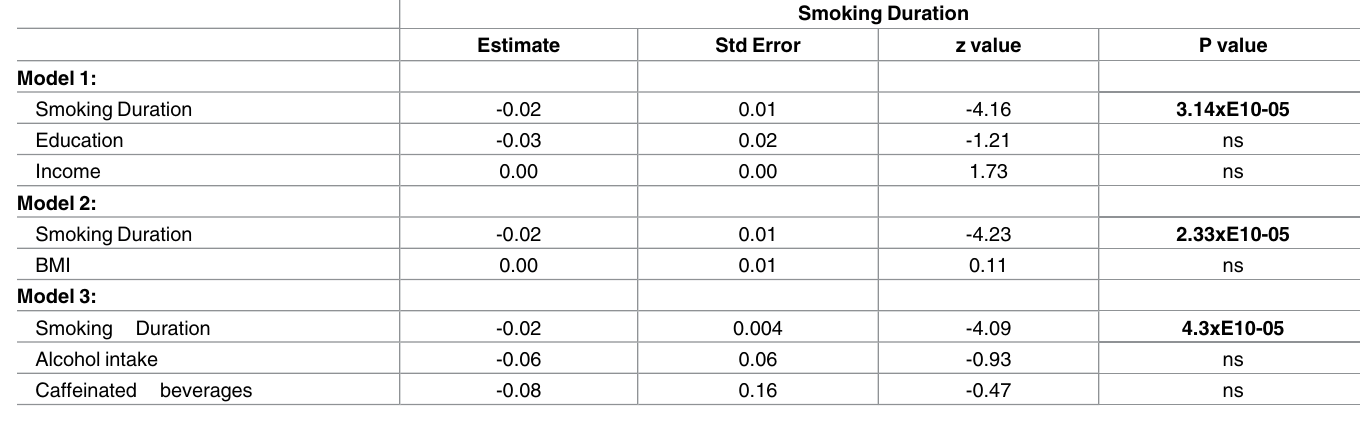
Table 5. Logistic Regression models exploring the effect of covariates of smoking on the risk of classification as Sjo¨gren’s Syndrome. The only significantpredictor was smoking duration. Smoking Duration Estimate Std Error z value P